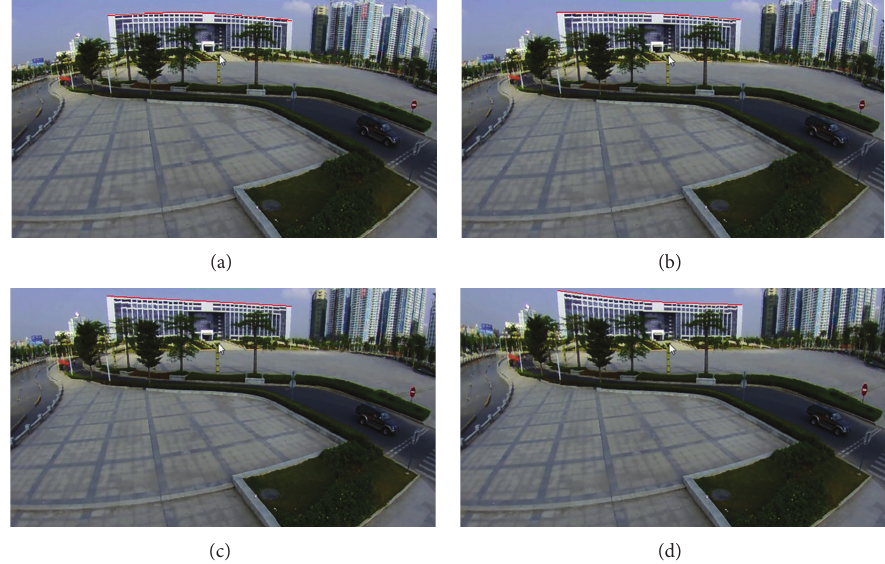
Figure 9: Different images after distortion correction with different Horizontal Distortion Redundancy Length (HDRL) values. (a) ∼ (d) show the corrected images when HDRL values are 60, 90, 120, and 140,